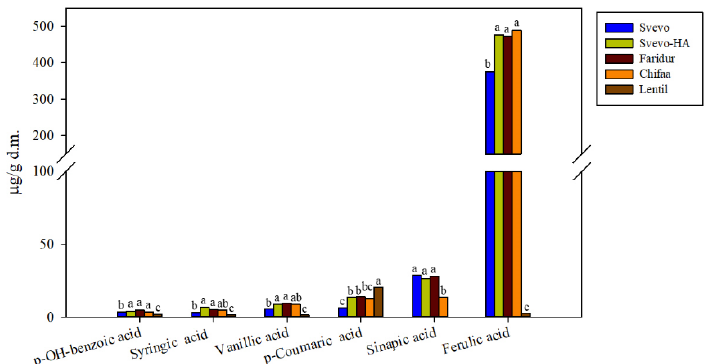
Figure 1. Content of individual phenolic acids expressed as µ g/g d.m. in the wholemeal flour of Svevo, Svevo-HA, Faridur, Chifaa and the elite lentil line 6002/ILWL118/1-1 wholemeal flours. a–c Different letters for each phenolic acid indicate significant differences between the samples ( n = 3, p < 0.05).